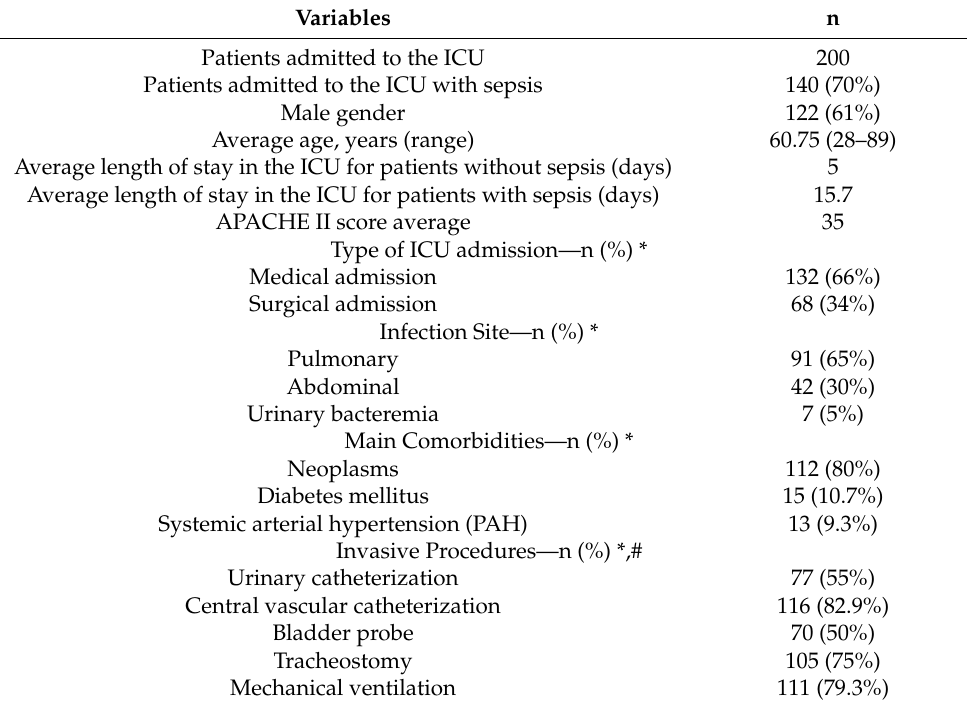
Table 1. Clinical features of patients admitted to the